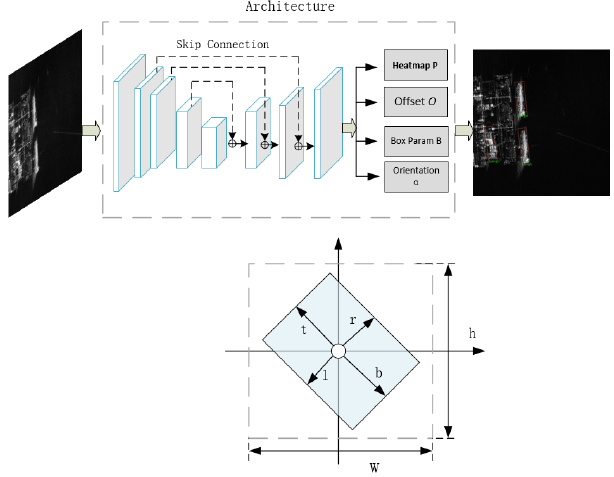
Figure 14. The network architecture of BBAVectors.